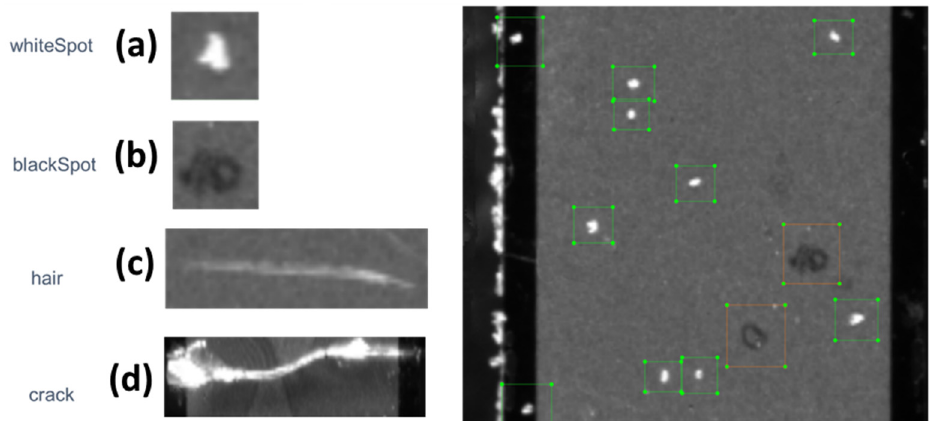
Figure 3. Different defects in plenoptic images. ( a , b ) represent small white and black spots, respec- tively, as a result of the accumulation of dust and dirt. ( c ), as the label suggests, is human hair, whereas ( d ) shows physical cracks on the surface of the specimen due to tension. The right side of the figure represents ( a , b ) labelled defects in green and orange rectangles, respectively.